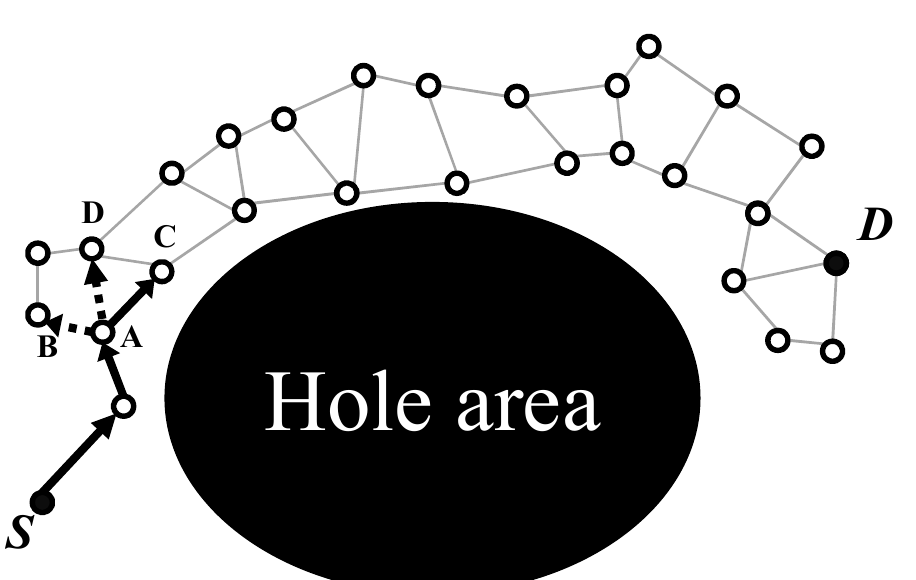
Figure 6. Local joint avoidance during multipath